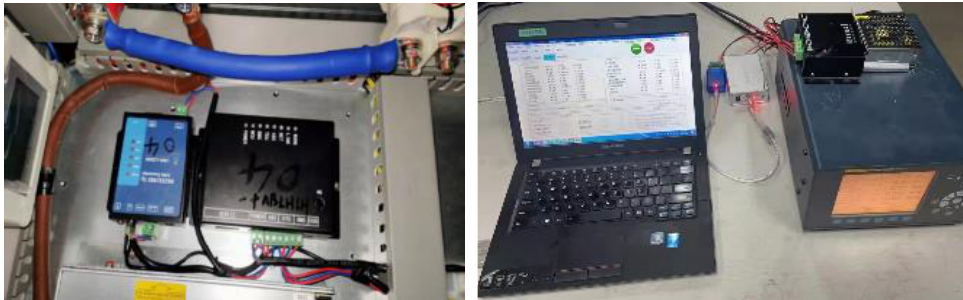
charging pile, and the right is the